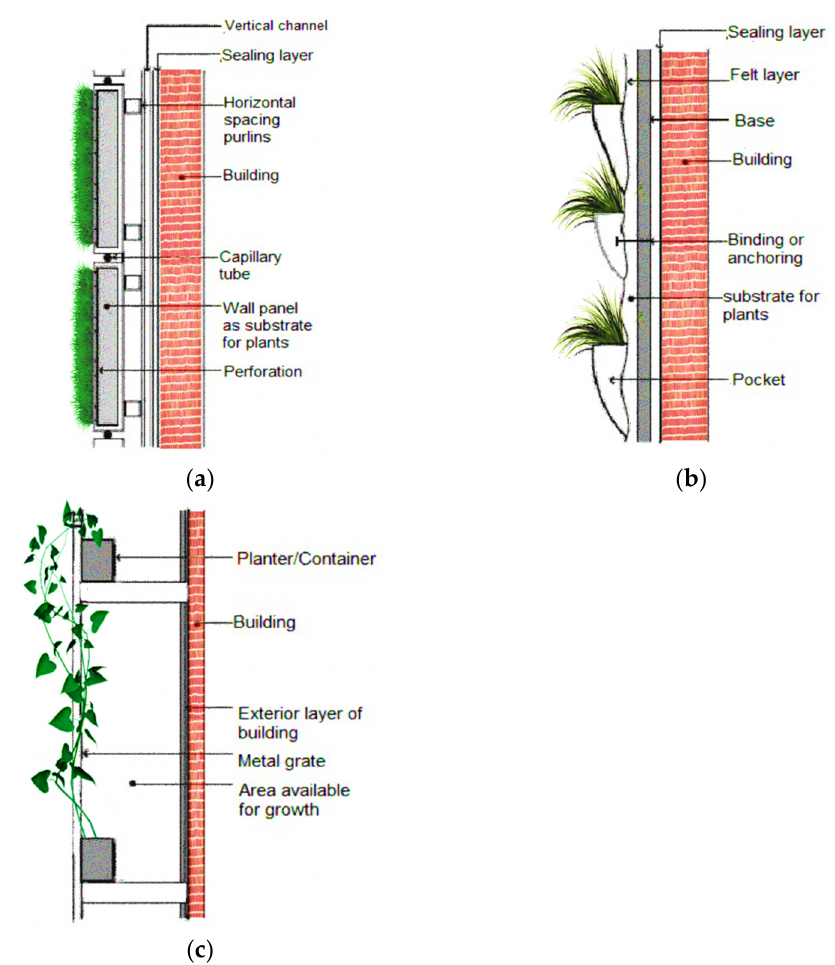
Figure 1. Variants of Existing vertical greening systems: ( a ) felt—hydroponic systems; ( b ) modular—using a substrate; ( c ) container technology—planting in pots.